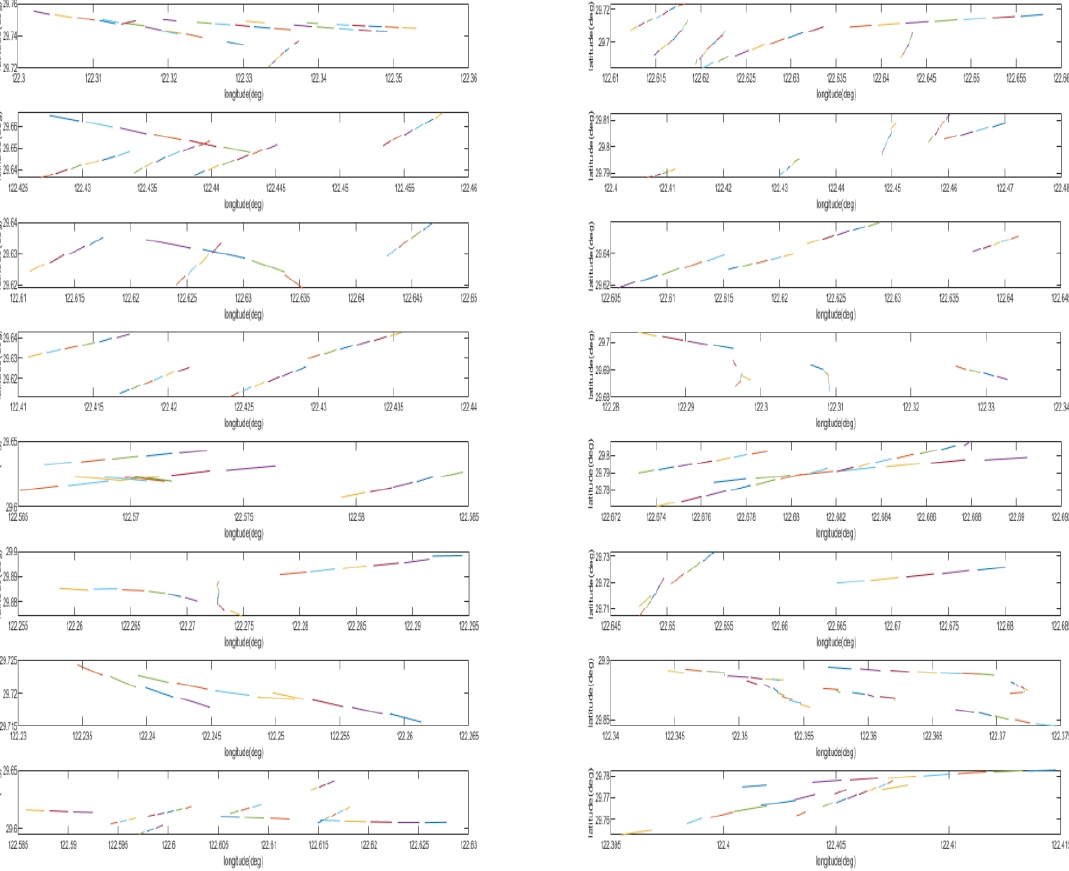
Figure 14. Historical encounter process statistics results.